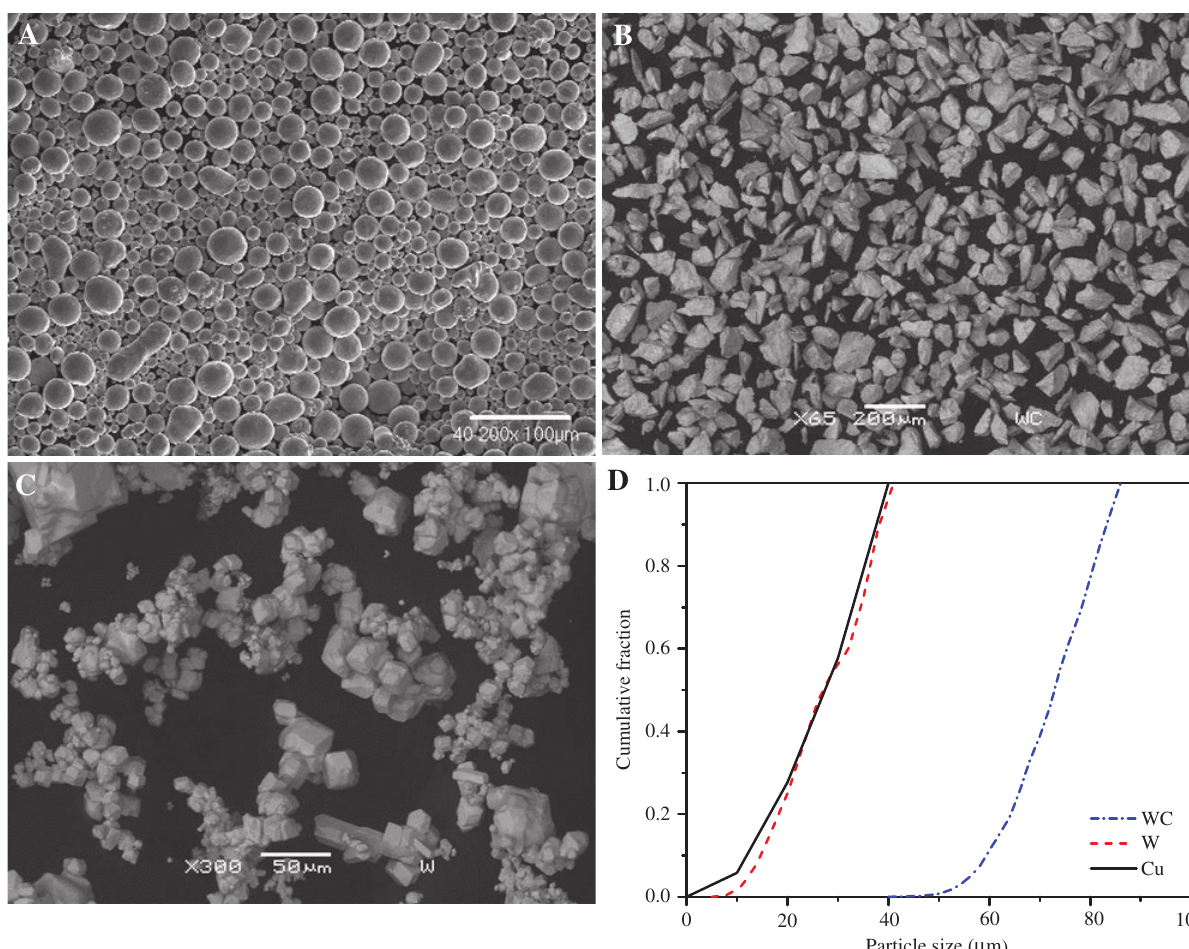
Figure 1: SEM micrographs of initial powders, (A) copper matrix, (B) WC, (C) W, and (D) particle size distribution of